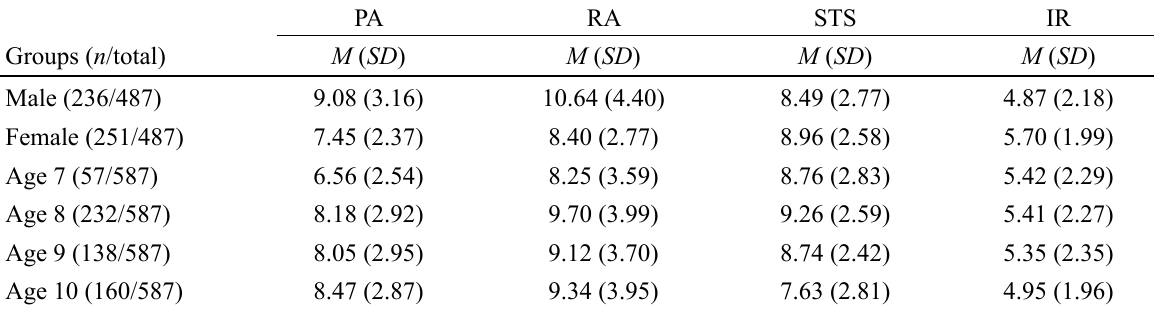
Table 5 Gender and Age Mean Scores on the PARB-Q PA RA STS IR Groups ( n